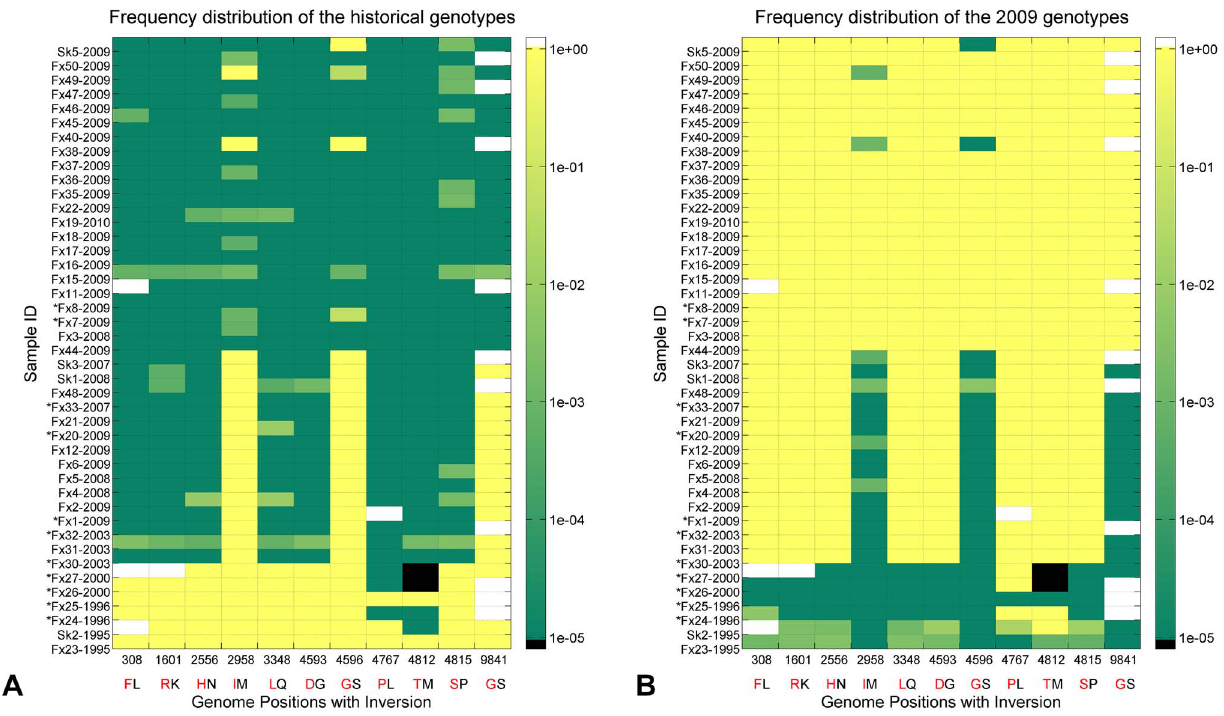
Figure 5. Heatmap showing the frequencies of the historical and outbreak haplotypes at 11 inversion sites for all samples. A . Frequency distribution of the historical haplotypes. Abscissa: genome locations where inversion of the consensus and variant amino acids occurred. Letters below the genome locations indicate the two haplotypes: red — consensus haplotypes in the historical samples, black —consensus haplotypes in the 2009 outbreak. Colorbar on the right indicates the frequency of the historical haplotypes in log scale. All entries of zero frequency were set to a floor of 10 2 5 so that they correspond to a valid logarithm value of -5 (dark green). Black entries denote samples that contained a third haplotype instead of the two main haplotypes. White entries denote missing samples. Ordinate: sample ID ordered from early to late collection date (though not strictly in the late samples) and south to north collection site. Asterisks indicate samples where only 454 data were available and thus have considerably lower coverage and decreased detection of rare variants. B . Frequency distribution of the inversion haplotypes found in the 2009 outbreak. Colorbar on the right indicates the frequency of the 2009 haplotypes in logscale. Dark green entries (1e-5) correspond to haplotype frequency of